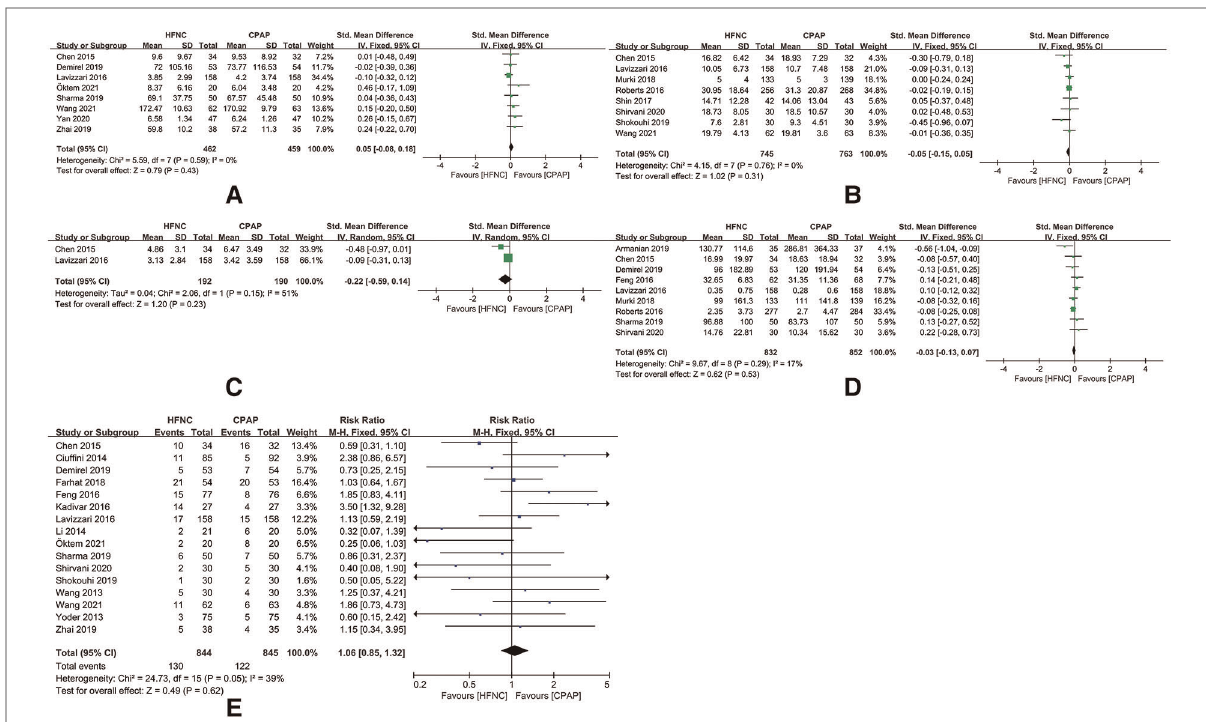
FIGURE 8 ( A ) Forest plot of comparison: HFNC vs. CPAP-duration-Non-invasive respiratory support (after removing “ Zhang 2017 ” and “ Zhang 2019 ” ). ( B ) Forest plot of comparison: HFNC vs. CPAP-age-Enteral feeding (after removing “ Zhang 2017 ” and “ Zhang 2019 ” ). ( C ) Forest plot of comparison: HFNC vs. CPAP-duration-Mechanical ventilation (after removing “ Zhang 2017 ” ). ( D ) Forest plot of comparison: HFNC vs. CPAP-duration-Oxygen therapy (after removing “ Zhang 2017 ” and “ Zhang 2019 ” ). ( E ) Forest plot of comparison: HFNC vs. CPAP-number-Respiratory support failure (after removing